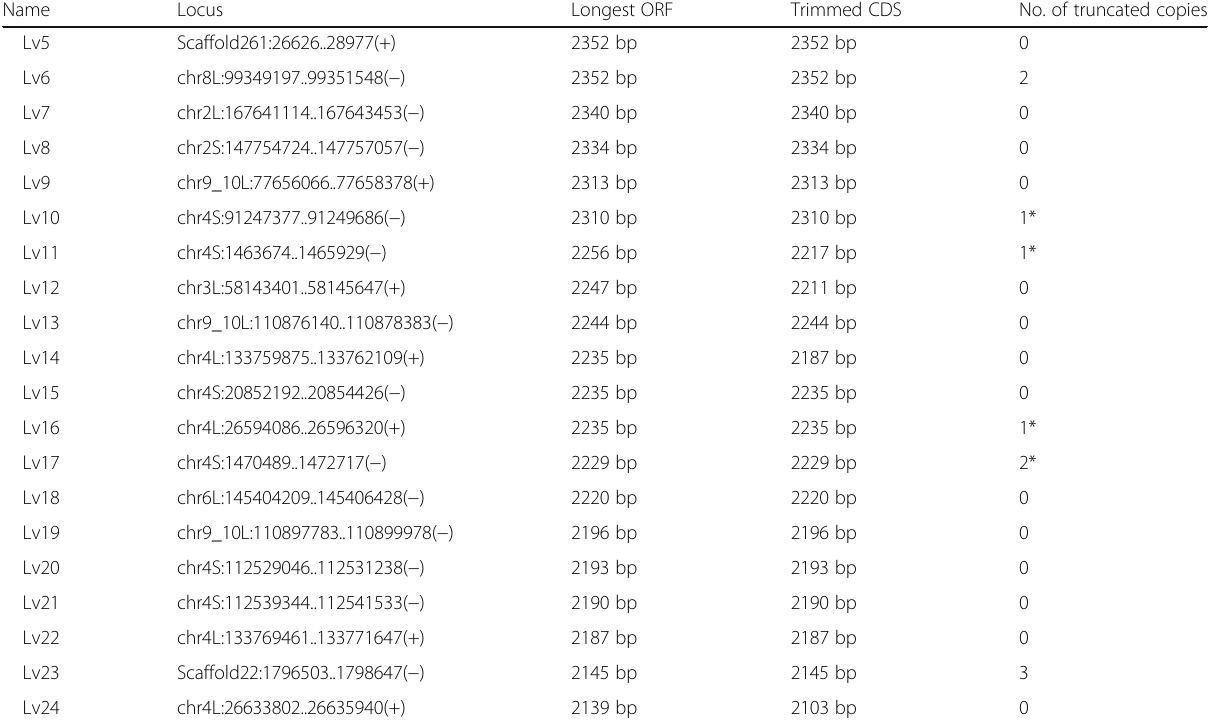
Table 1 Prospective Xenopus XKol transposase CDSs